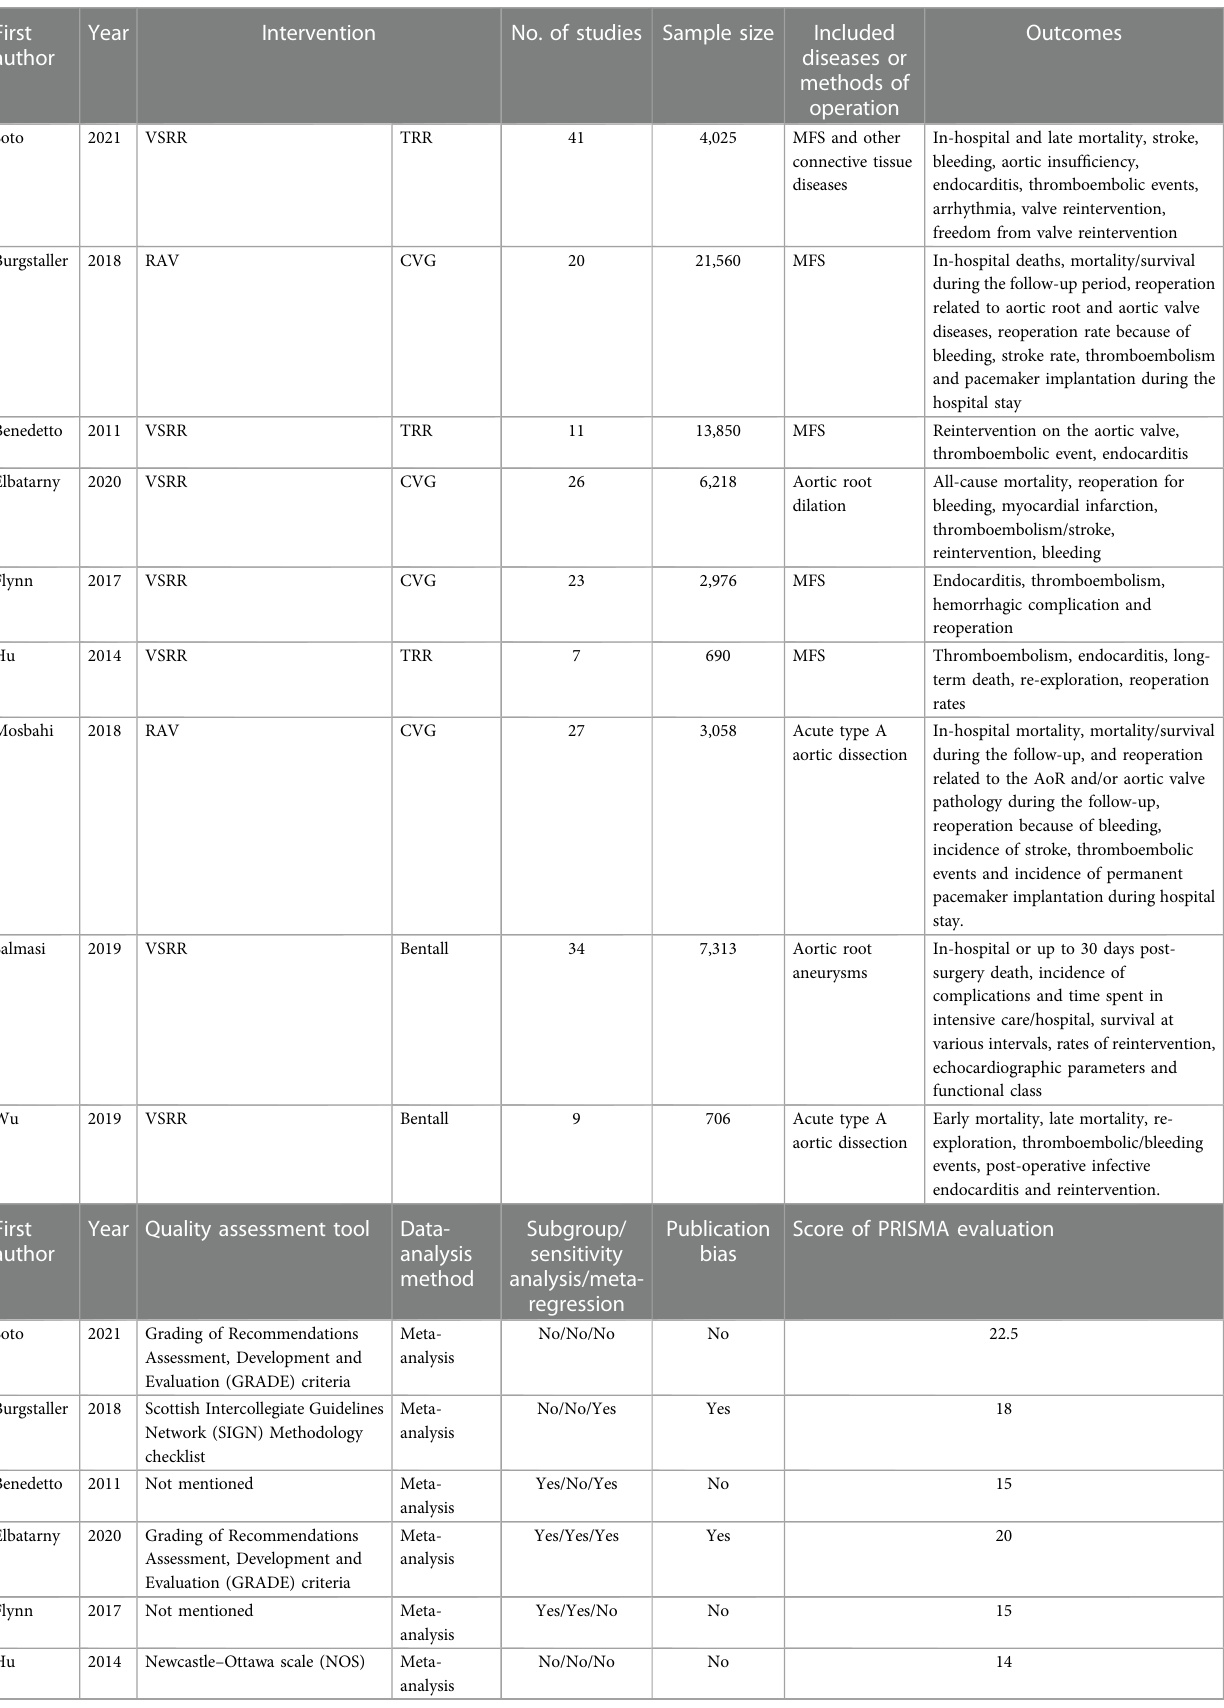
TABLE 2 Characteristics of the included systematic reviews and the score of PRISMA